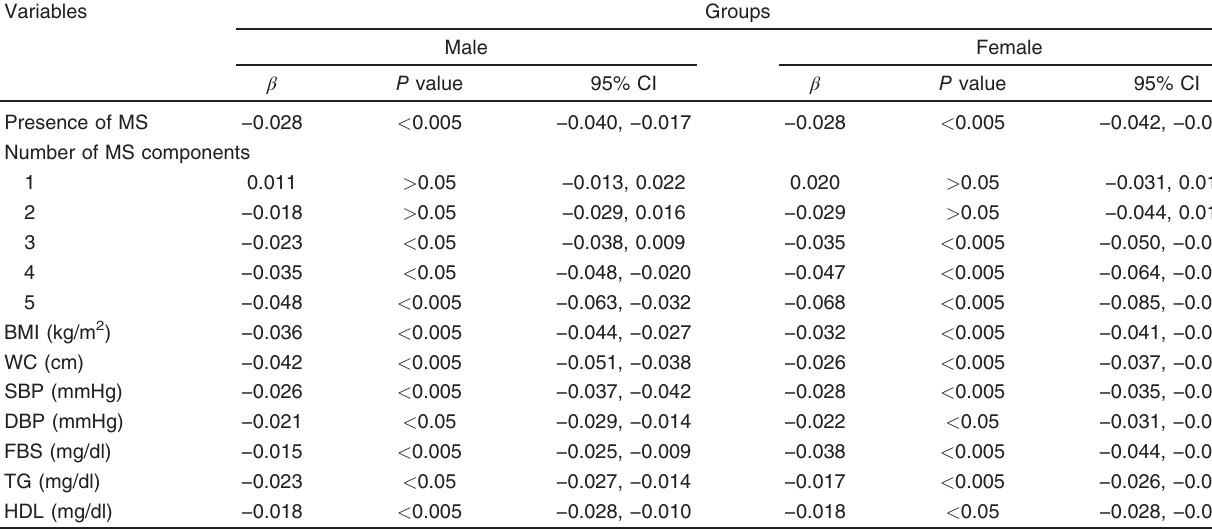
Table 6 Regression coefficients of the components of metabolic syndrome for forced vital capacity percent predicted Variables